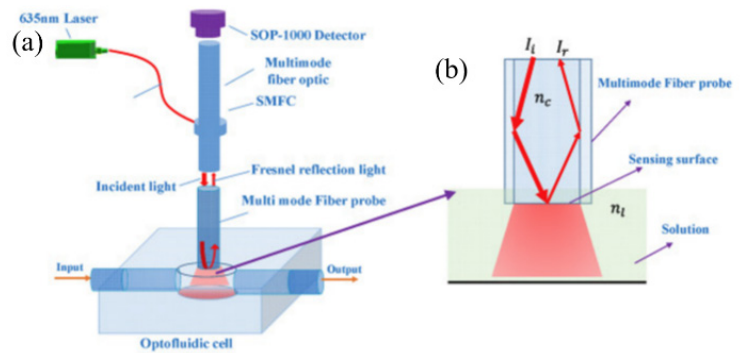
Figure 3. The schematic diagram of ( a ) the optofluidic biosensor based on Fresnel reflection and ( b ) the fiber probe immersed in liquid. Reprinted with permission from [59].